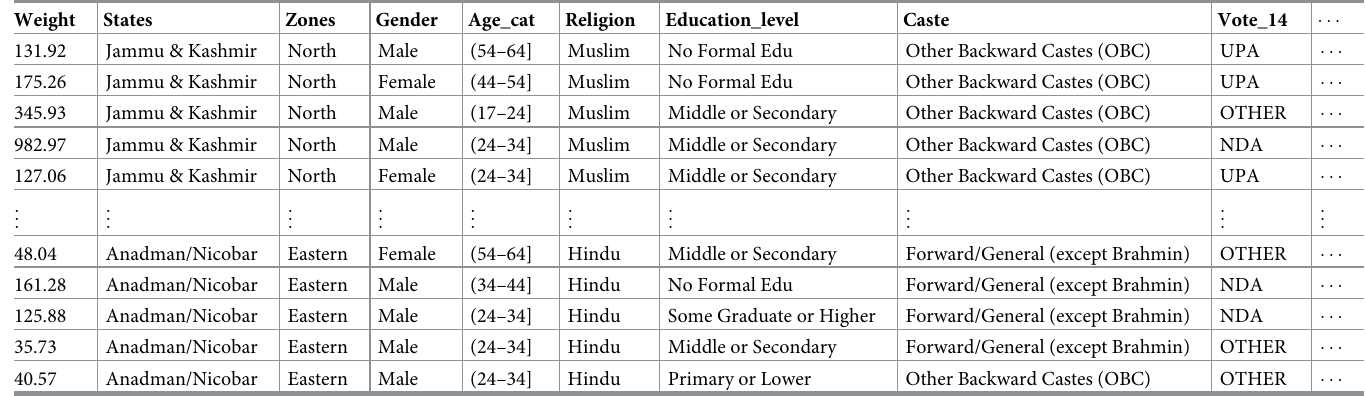
Table 2. Subset of the complete stratification frame, aggregated at the